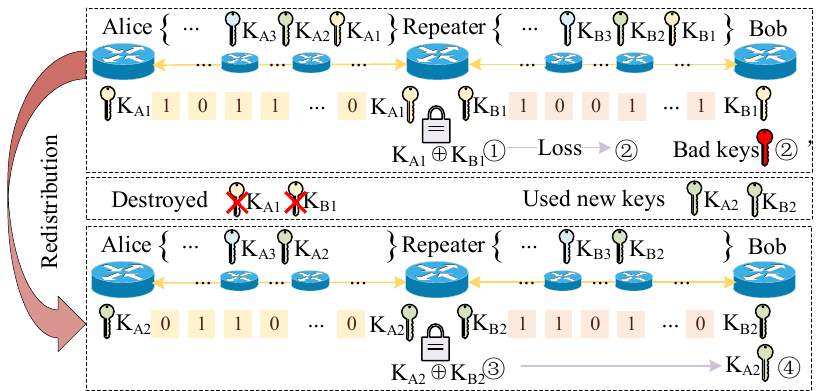
Figure 4. In the case of multi-hop relay, when a certain relay fails, the problem caused by the traditional QKD scheme.